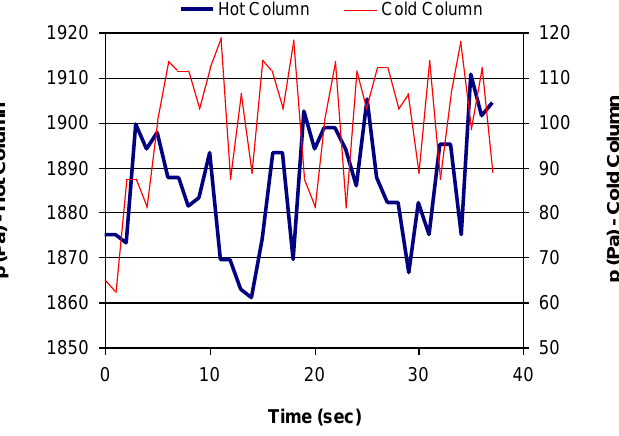
Figure 3. Comparison of pressure drops in the two columns during full fluidization.